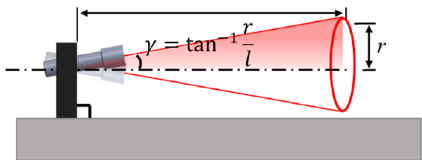
Figure 10. Orthogonal calibration of the laser module.